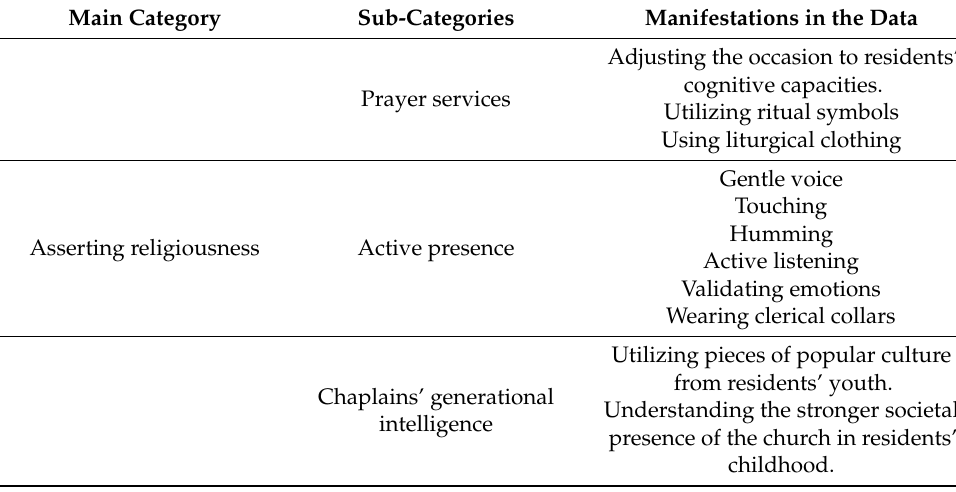
Table 3. Analysis of asserting